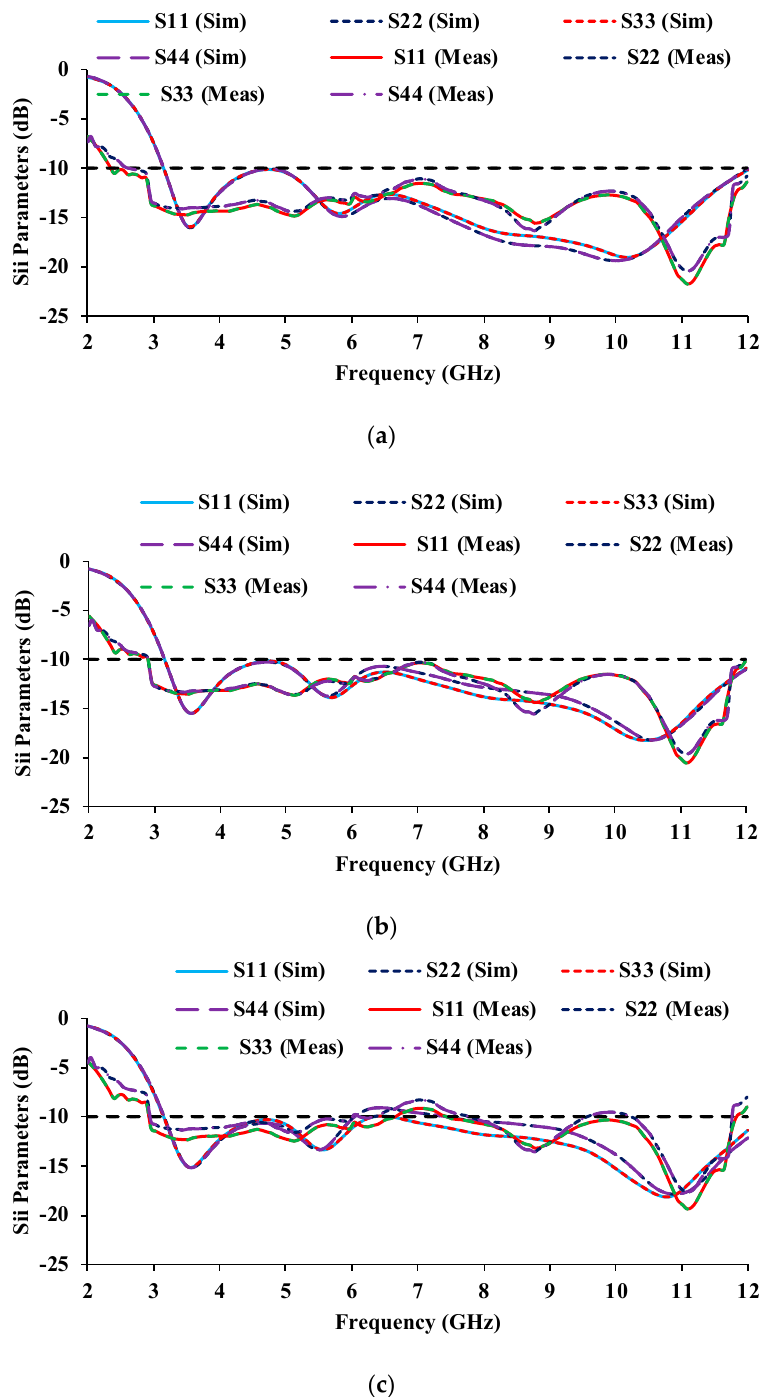
Figure 19. Reflection coefficients of the antenna at three bending radii ( a ) BR = 25 mm, ( b ) BR = 20 mm, ( c ) BR = 15 mm. Table 1 shows that the proposed MIMO flexible antenna can bend up to a bending angle of 146.2 ◦ , and the critical bending angle of the proposed antenna is 194.9 ◦